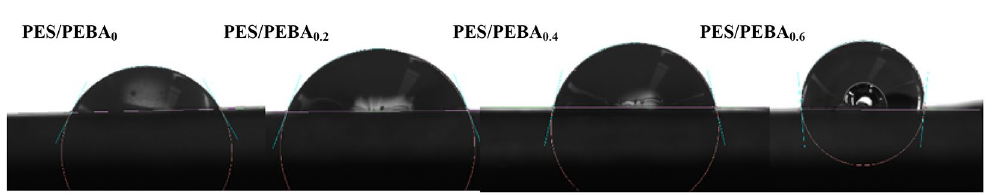
Figure 5. Contact angle of modified PEBA membranes with different fumed silica